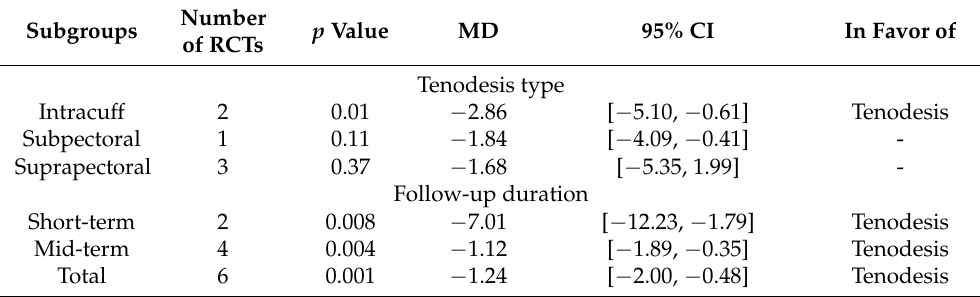
Figure 3. Meta-analysis of randomised controlled trials showing that Constant scores were better in the patients who underwent tenodesis. Green symbol: mean difference value; Black symbol: result of meta-analysis [17,19,23,30,32,33]. Table 2. Summary of subgroup analyses of Constant scores.